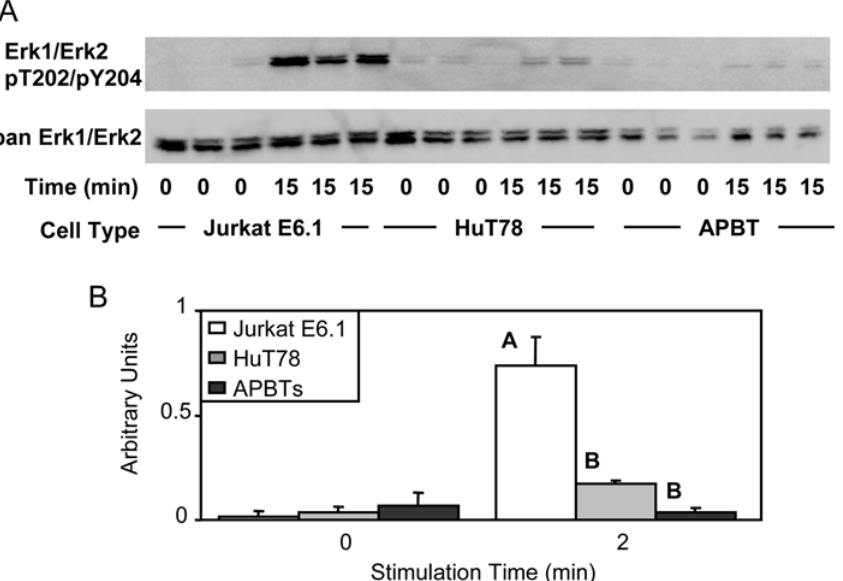
Figure 10. Jurkat E6.1 T cells have hyperphosphorylated Erk1/Erk2 compared to HuT78 T cells and APBTs. (A) Three samples of Jurkat E6.1 T cells, HuT78 T cells, and APBTs were stimulated and the cellular proteins were separated by SDS-PAGE. The site-specific phosphorylation and expression of Erk1 and Erk2 was assessed by immunoblotting using Erk1/Erk2 pT202/pY204 (top) and pan-Erk1/Erk2 (bottom) antibodies. (B) The immunoblots were analyzed by densitometry and the ratio of the intensity of the phosphospecific Erk1/Erk2 bands to the pan-Erk1/Erk2 bands for each cell line for three separate experiments was averaged. Letters represents significant differences of p , 0.005.